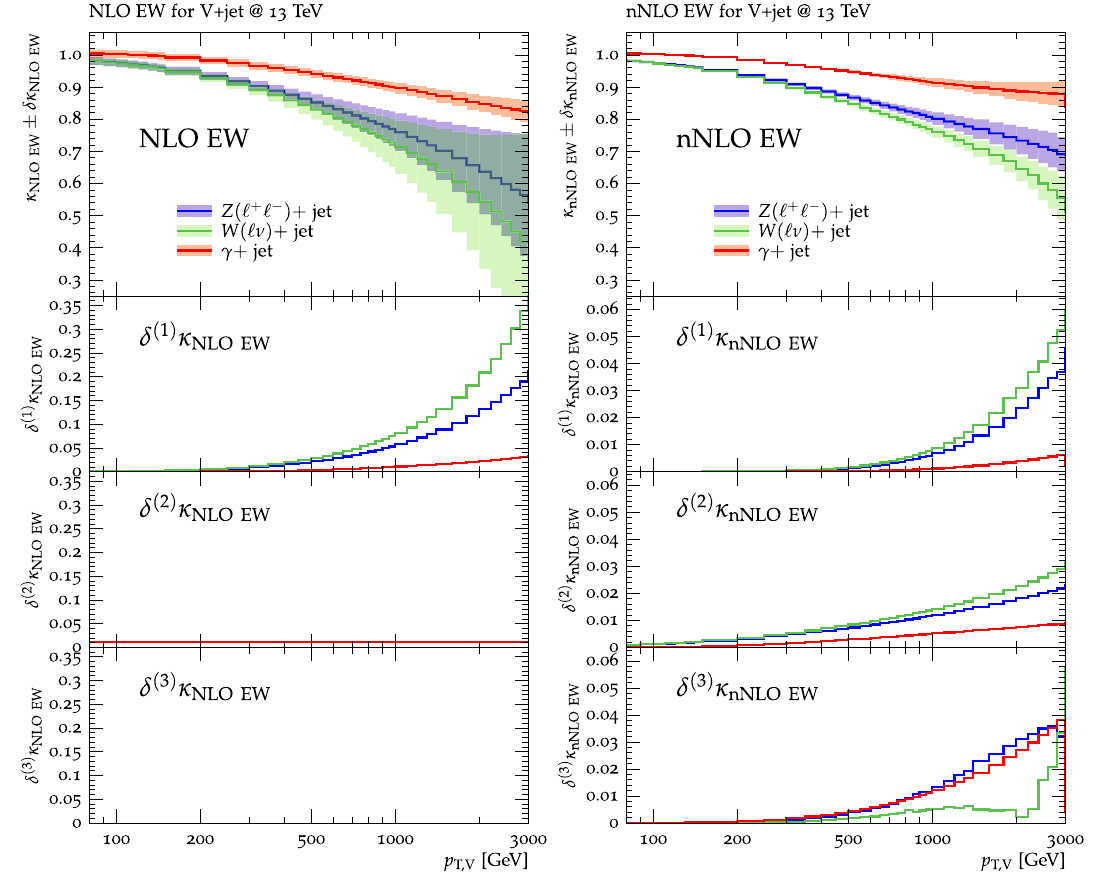
Fig. 10 NLO EW (left) and nNLO EW (right) κ -factors for the various pp → V + jet processes at 13TeV. The individual uncertainties δ ( i ) κ ( V ) are defined in Eqs. (52), (53) and (56), at nNLO and in Eq. (57) at NLO. The bands in the main frame correspond to their combination in